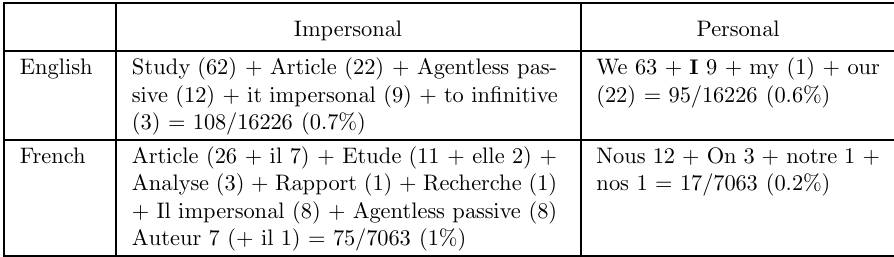
Forms of self-reference Impersonal Personal